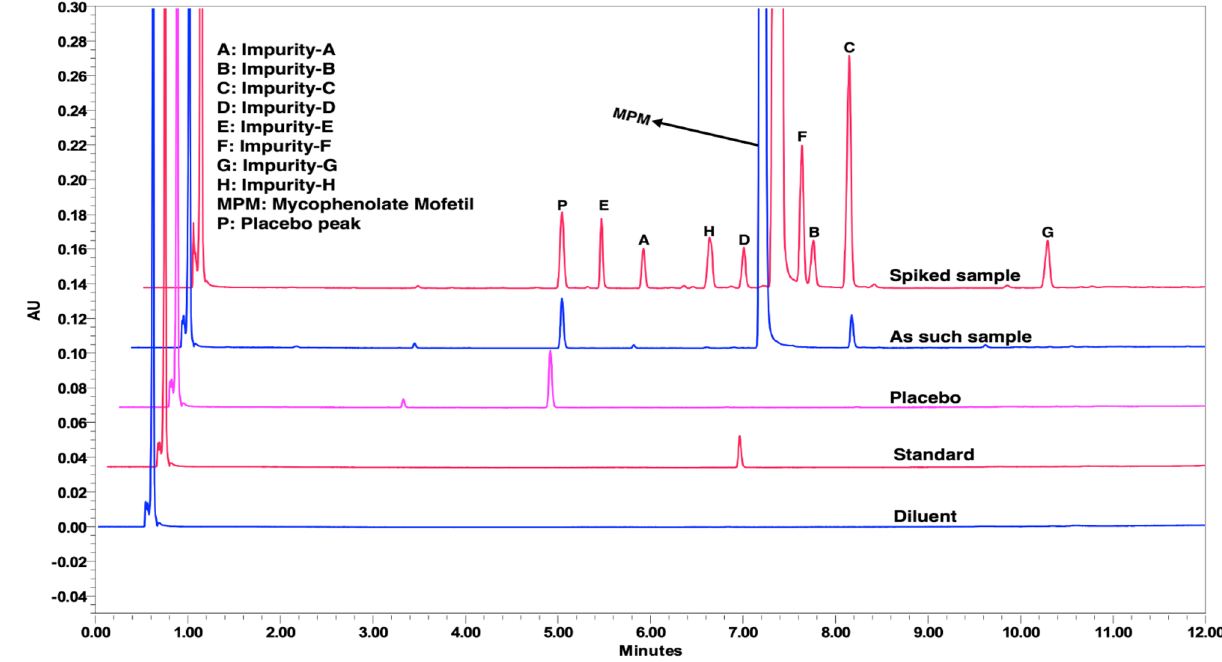
Figure 4. Interference study chromatograms from the final method. Chromatographic conditions: MP-A: pH 4.05 KH 2 PO 4 (25 mM); MP-B: Water: ACN = 30:70 (v/v); Initial gradient composition MP-A:MP-B (87:13); Column: Acquity UPLC BEH C18 (100 mm × 2.1 mm), 1.7 µm; Flow rate: 0.4 mL min −1 ; Column temperature: 30 °C; Injection volume: 5 µL; and Wavelength detection: 215 nm.